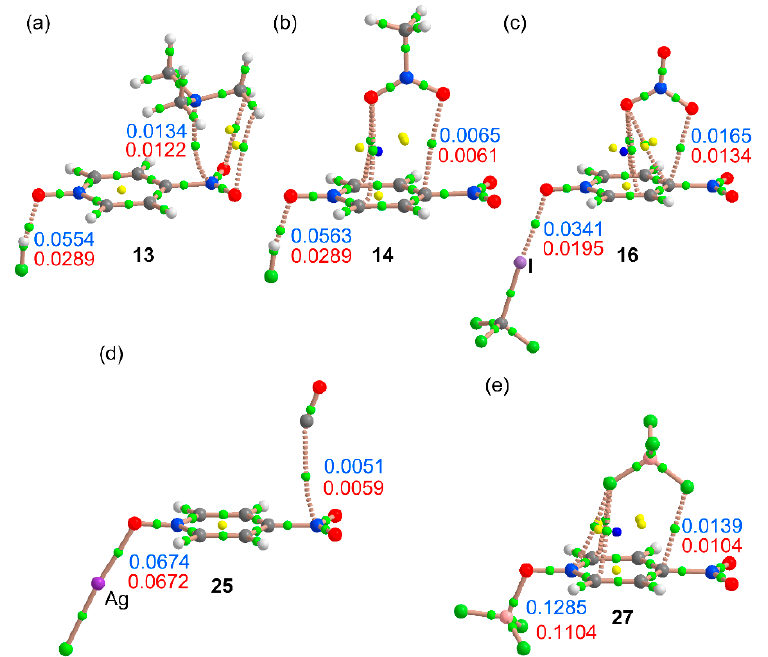
Figure 7. Distribution of bond ring and cage CPs (green, yellow, and blue spheres) and bond paths in ternary complexes 13 ( a ), 14 ( b ), 16 ( c ), 25 ( d ) and 17 ( e ). The values of ρ (r) (a.u.) at the bond CPs that characterize the noncovalent interactions in the ternary complexes are given in blue and their corresponding values in the related binary complexes are indicated in red.